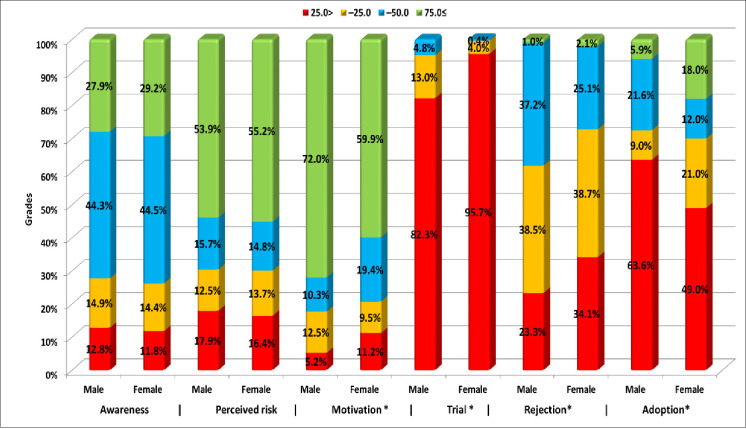
Gender differences in grading scores of behavior development levels.